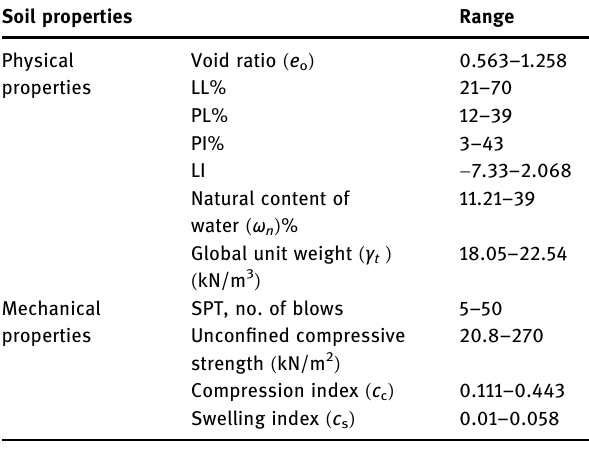
Table 2: The properties of the soil according to laboratory Tests Soil properties